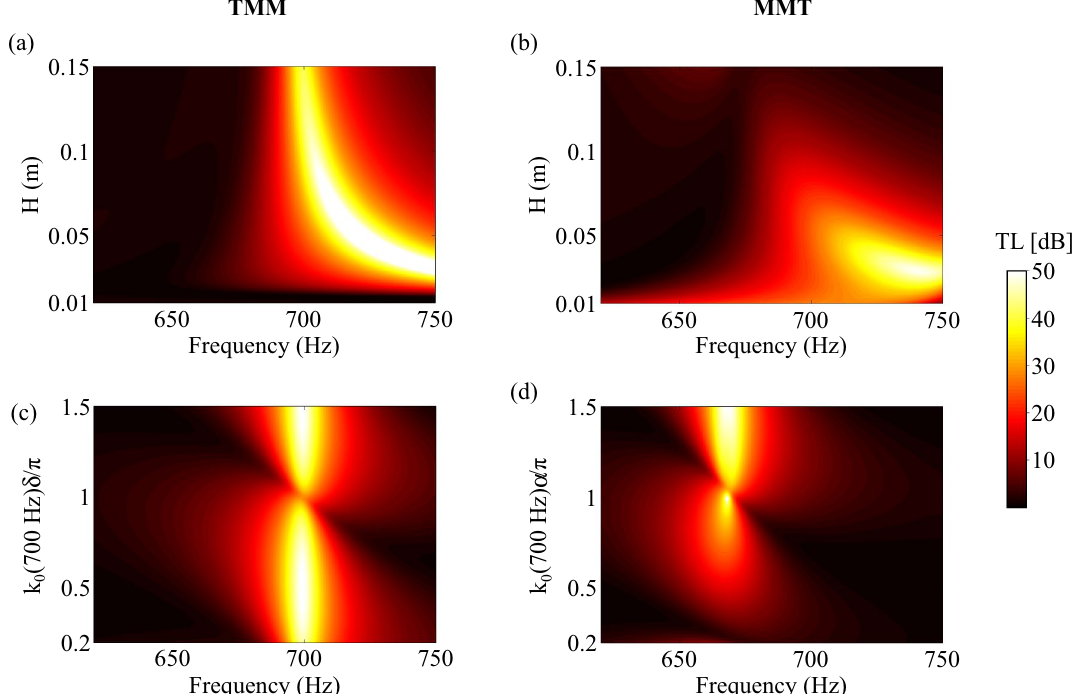
Figure 4. TL predictions of a FMAA composed of two identical and axially spaced HRs. The predictions are either performed by the TMM ( a , c ) or by the MMT ( b , d ). In ( a , b ), the distance between the HRs 5 cm and the height of the duct, H , varies between 1 and 15 cm. In ( c , d ), δ is δ = π , and H 15 k 0 ( 700Hz )δ 0.2 1.5 = ∈ [ ; ]